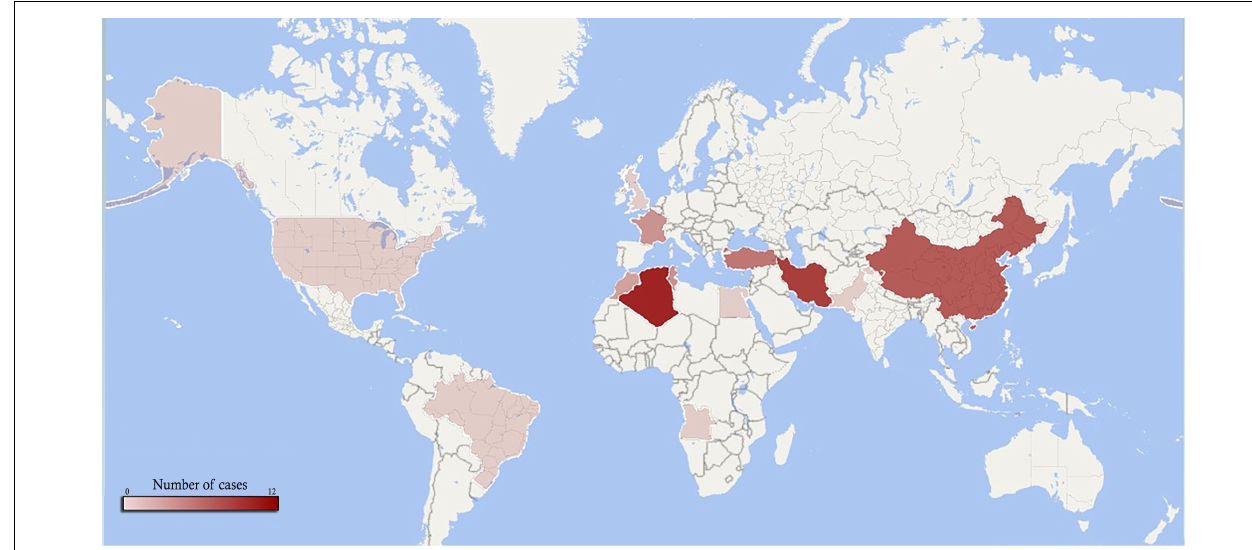
FIGURE 1 | The worldwide distributions of fungal infection cases with CARD9 deficiency.